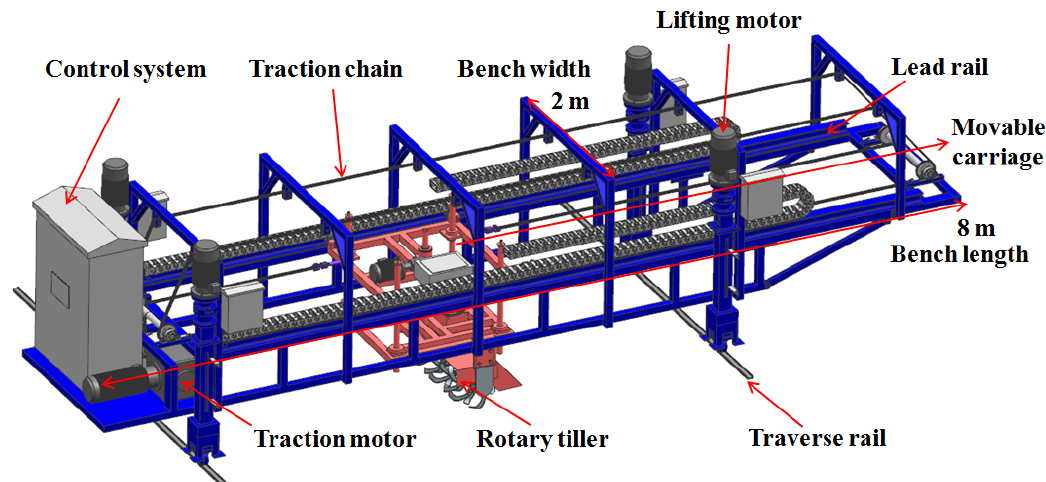
Figure 1. Schematic structure of field test rig.